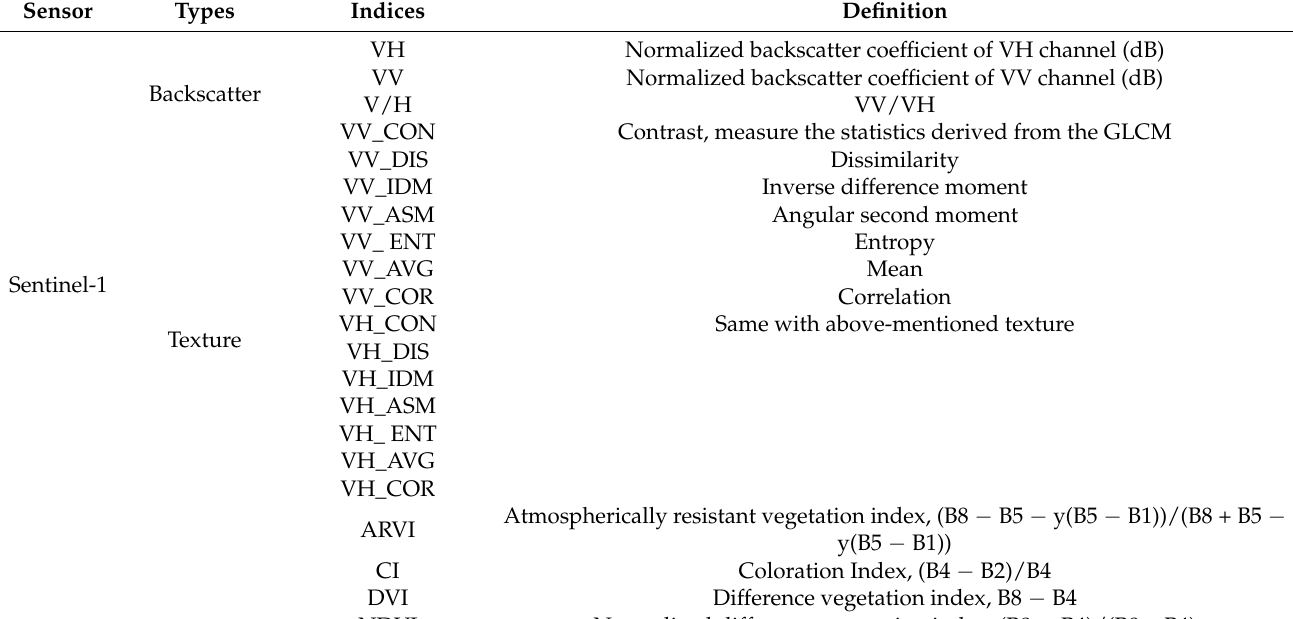
Table 2. Remote sensing indices from ALOS-1DEM, Sentinel-1 SAR, and Sentinel-2 MSI for forest LAI